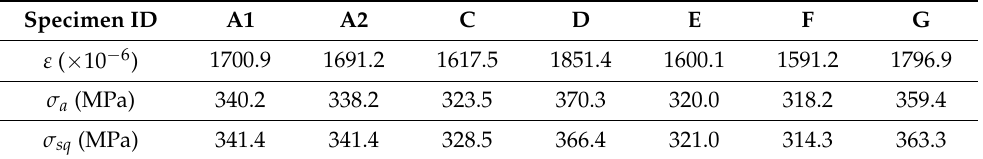
Table 8. Comparison between different methods.